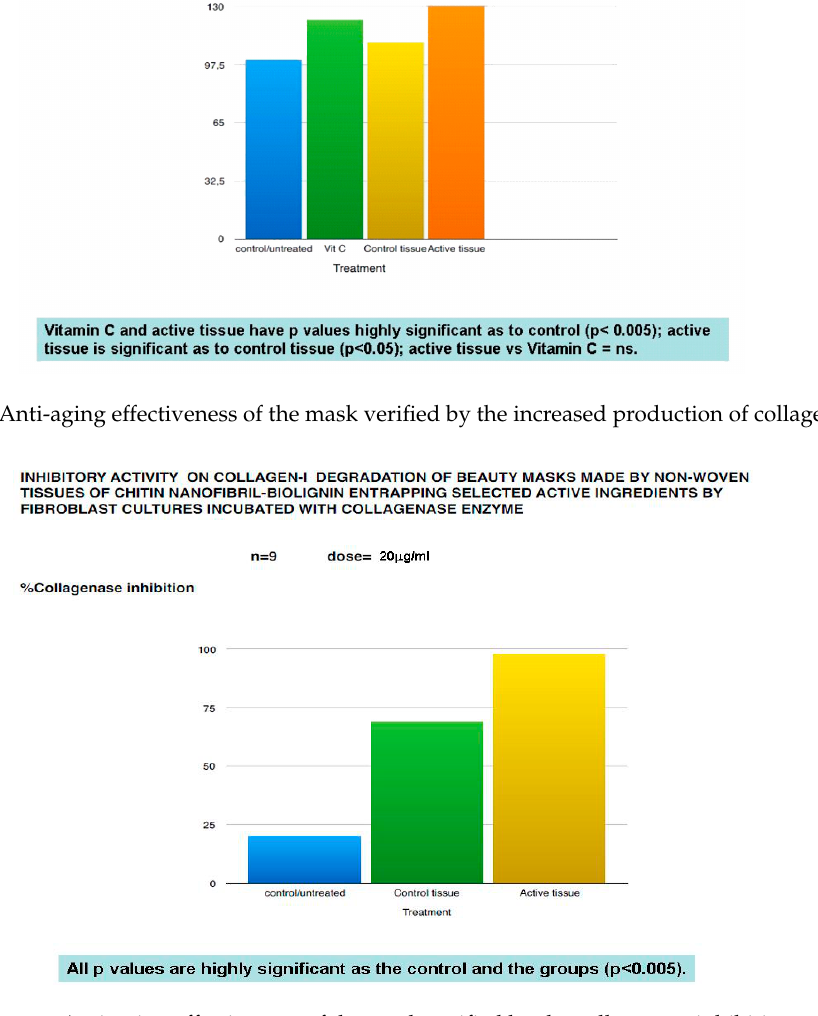
Figure 7. Anti-aging effectiveness of the mask verified by the collagenase inhibition.